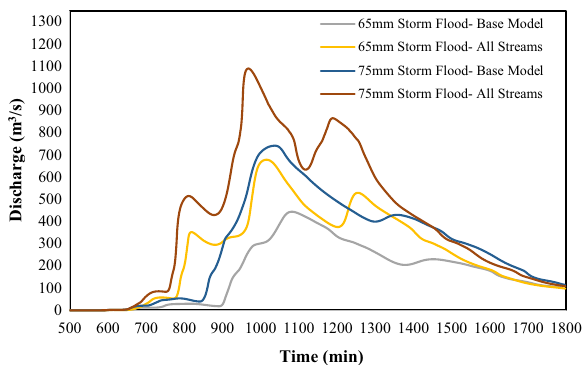
Fig. 15 Flood hydrographs of calibrated GSSHA base model for three 24 h floods of 60, 70 and 80 mm cumulative depths compared to Hydrographs corresponding to GSSHA model by modeling all watercourses with a drainage area of greater than 5 km 2